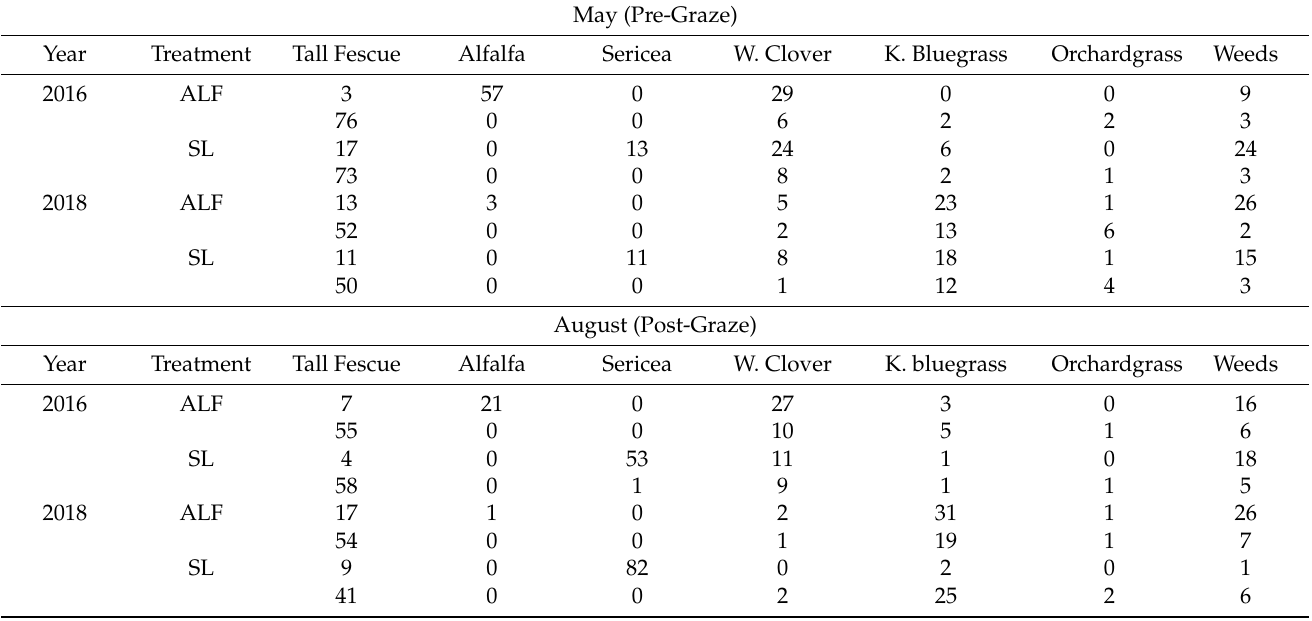
Table 3. Percent ground cover of major forage species and weeds in the legume-interseeded treat- ments (ALF and SL). Measurements were taken before grazing started in May and when animals were removed in August (2016 and 2018). Sampling was stratified in treatment plots—mean cover values in first row represent interseeded legume strips, and values in second row represent tall fescue swards. Bare ground and senescent vegetation cover values are not shown, so totals may not equal